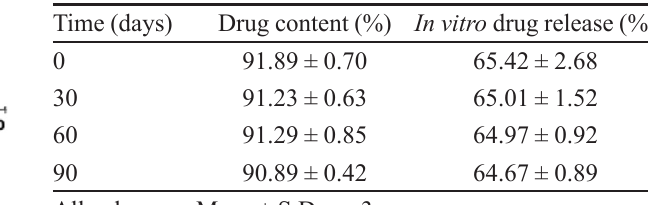
TABLE IV - Physicochemical evaluation of solid dispersion after stability